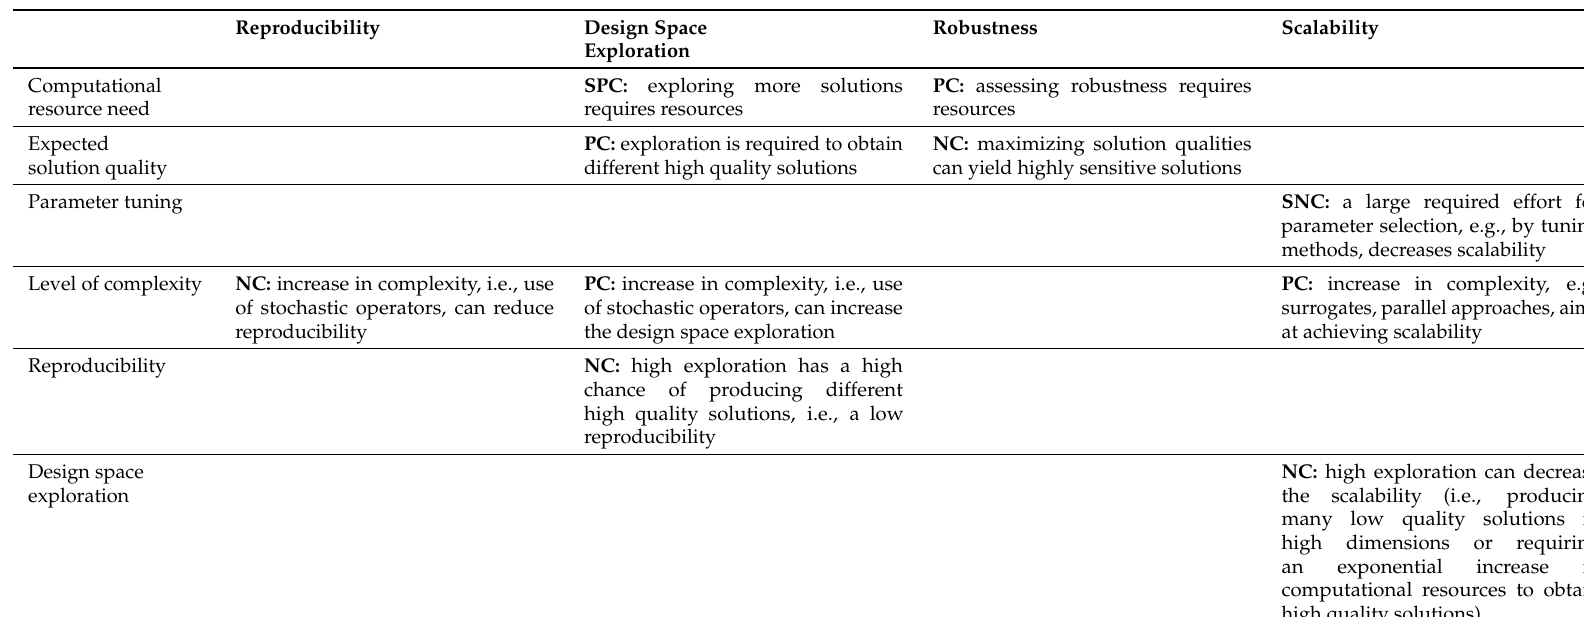
Table A2. Part 2 of correlations between the quality criteria for the Decision Matrix. The correlations are: SPC , strong positive correlation; PC , positive correlation; NC , negative correlation; SNC , strong negative